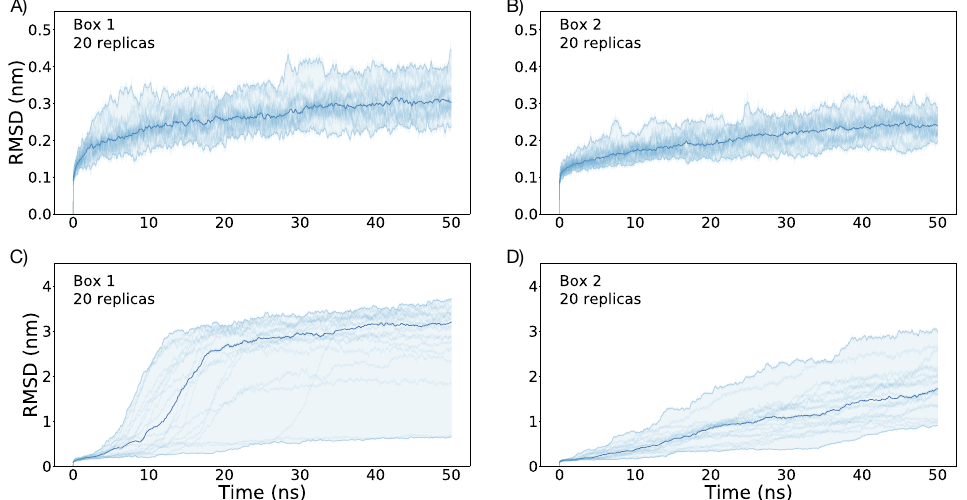
Figure 4. RMSD calculated using the lsq fit procedure in GROMACS as a function of time for all the replicas after 50 ns of simulation time under a (cid:126) E = 0.1 V/nm, ( A , B ); and under (cid:126) E = 0.2 V/nm, ( C , D ). RMSD trajectories obtained from each replica are plotted in light blue, and the largest de- viation, the lowest deviation and the mean are depicted in dark blue, after the application of a LOWESS